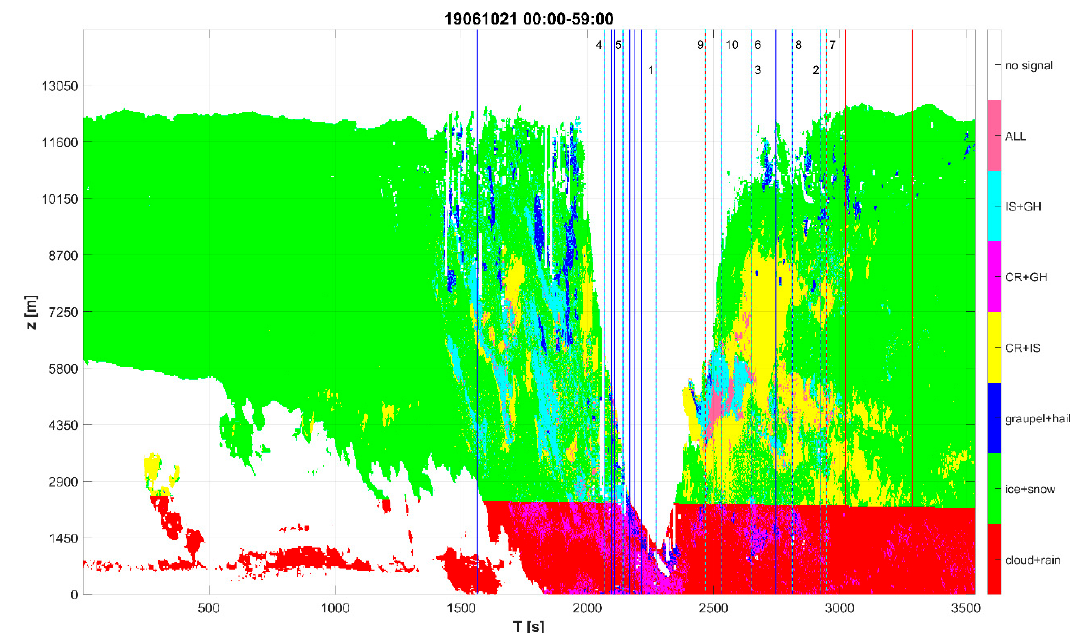
Figure 6. Hclass during the thunderstorm on 10 June 2019 from 21:00 to 21:59 UTC at the Milešovka observatory. Vertical lines depict NL discharges; blue lines depict CC NL discharges, red lines the CG NL discharges. Ten lightning discharges closest to the observatory are numbered in ascending order starting from the closest discharge denoted no. 1. Dashed lines represent cases, when more CG/CC discharges occurred around the same time (order of ms). Note that capital letters in the legend indicate first letter of classified hydrometeors (Table 2) and y-axis (z [m]) displays the height in meters above the cloud radar situated at an elevation of 837 m a.s.l.